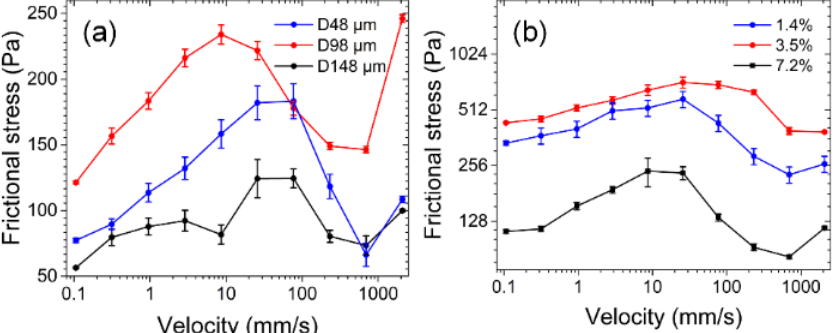
Figure 8. Effects of the diameter and porosity of circular micro-pits on frictional stress at the hydrogel– titanium alloy interface. micro-pit diameter ( a ) and porosity ( b ).